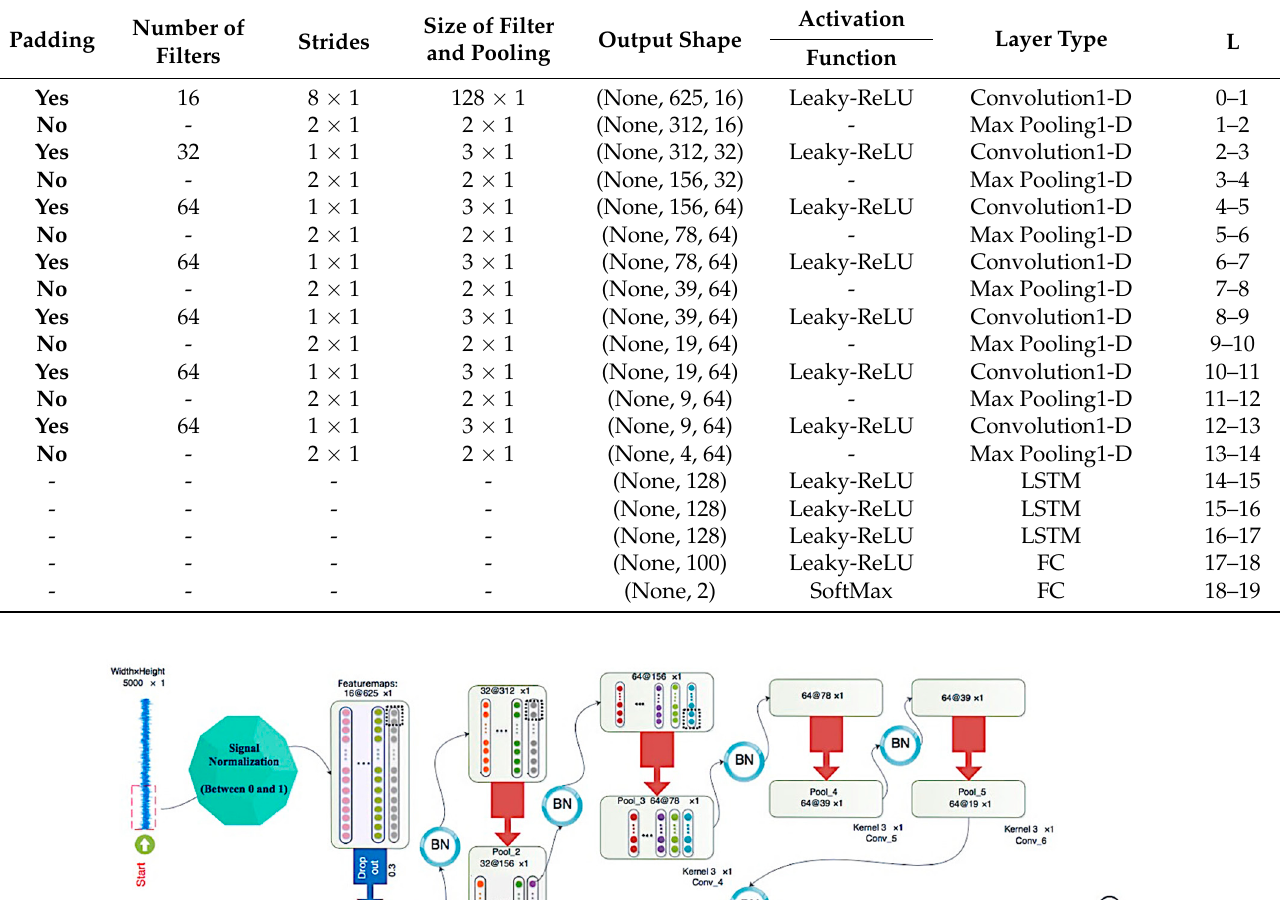
Table 1. The details of the suggested network.